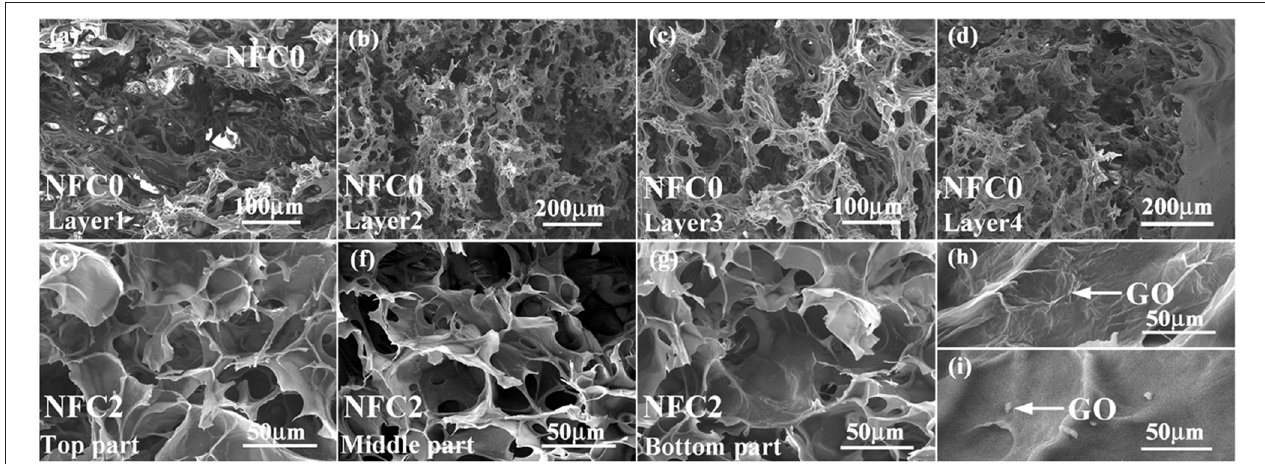
FIGURE 4 | Microstructure characteristics of different parts in (a–d) nanofibrillated cellulose 0 (NFC0), (e–g) NFC2 and GO distribution patterns in (h) the top and (i) middle parts of